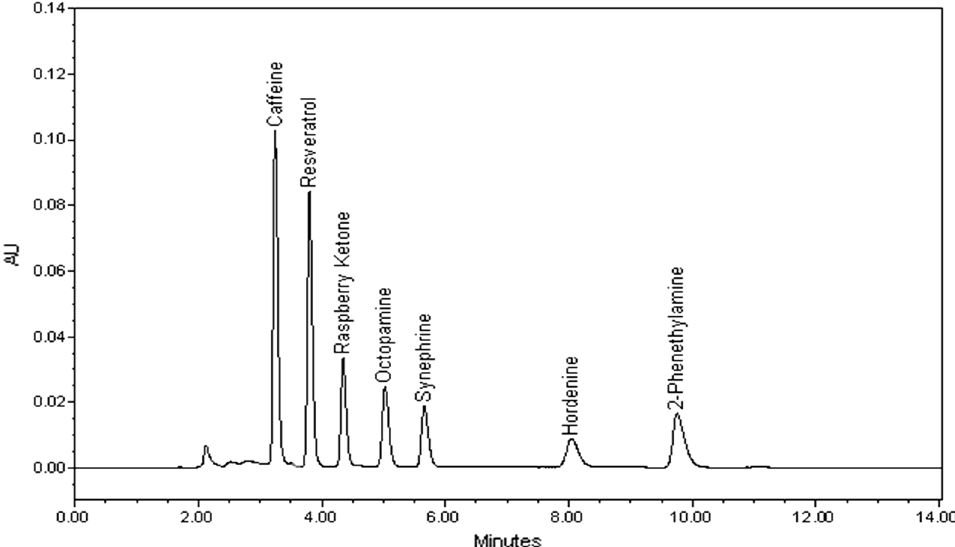
Figure 1. HPLC–PDA chromatogram of standard solution of the studied drugs at 205 nm for caffeine and 2-phenethylamine, 225 nm for Raspberry Ketone, p-Octopamine, p-Synephrine, p-Hordenine and 305 nm for trans-Resveratrol (2 µg/mL